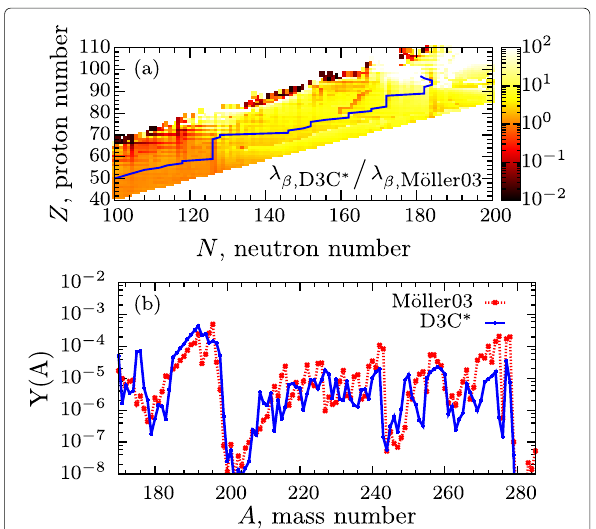
Fig. 3 a The ratio of β -decay rates from D3C ∗ [76] and Möller03 [75] models. The blue line shows the r -process path obtained from a calculation with Y e = 0.07, an initial entropy per nucleon s = 10 k B , and a dynamical timescale τ = 10 ms, using the FRDM mass model and the D3C ∗ β -decay rates at the time when R n / s = 1. b The comparison of abundances for A ≥ 170 using the same trajectory. Both lines are with the FRDM mass model, while the D3C ∗ (Möller03) β -decay rates are used for the blue (red)